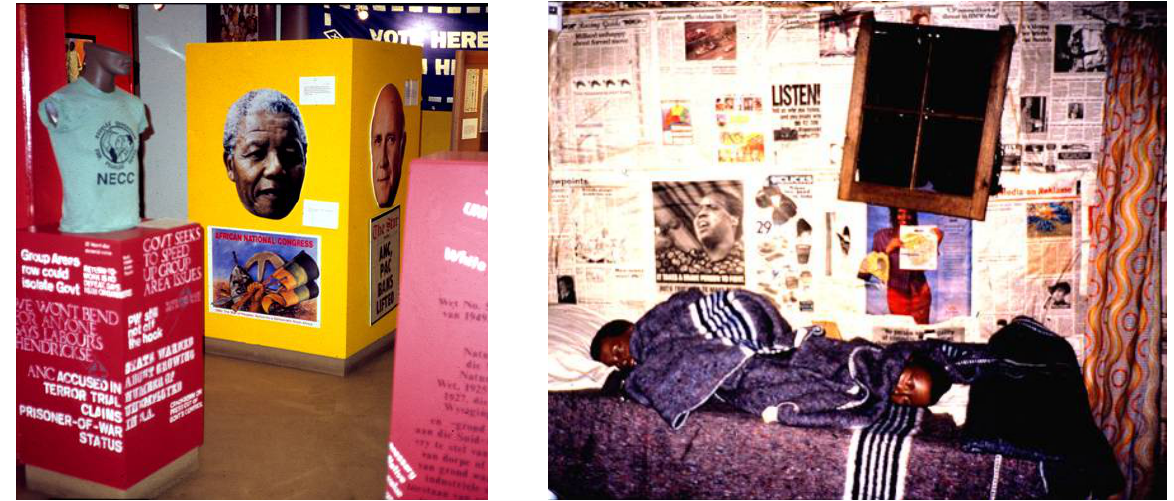
Figure 4. First free election exhibit, and interior of shack dwelling on display, Museum Africa, Johannesburg (author’s